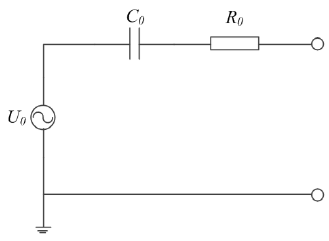
Figure 3. Capacitive divider equivalent model.